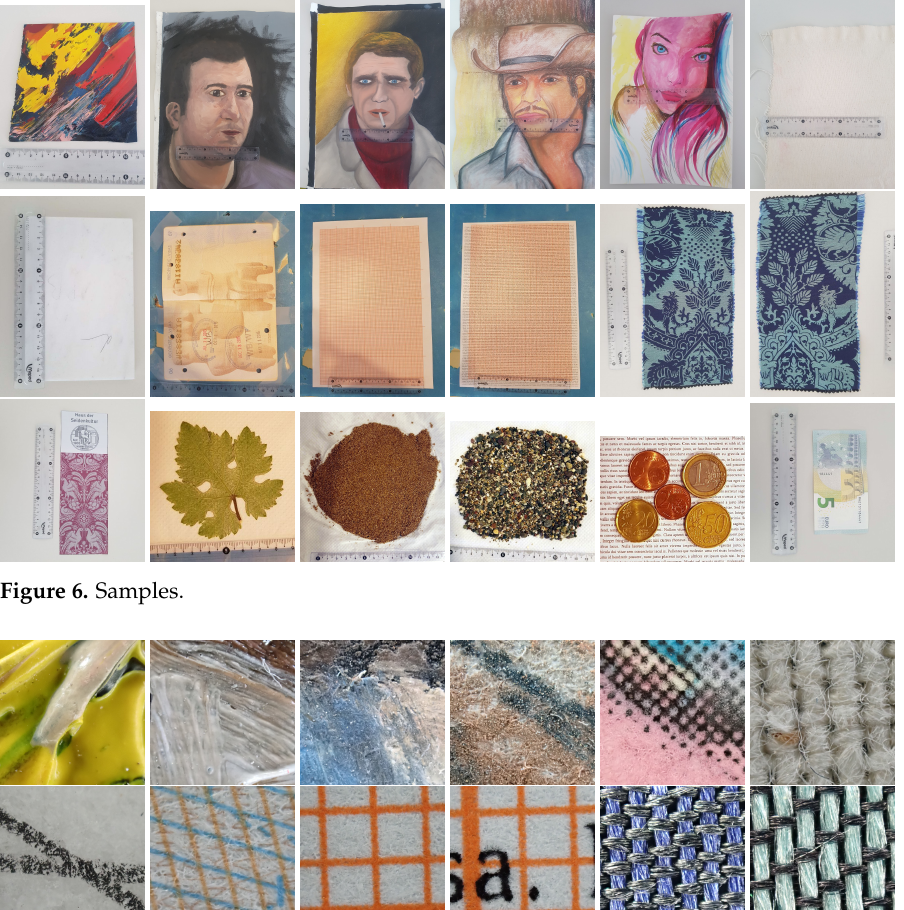
Figure 7. Sample